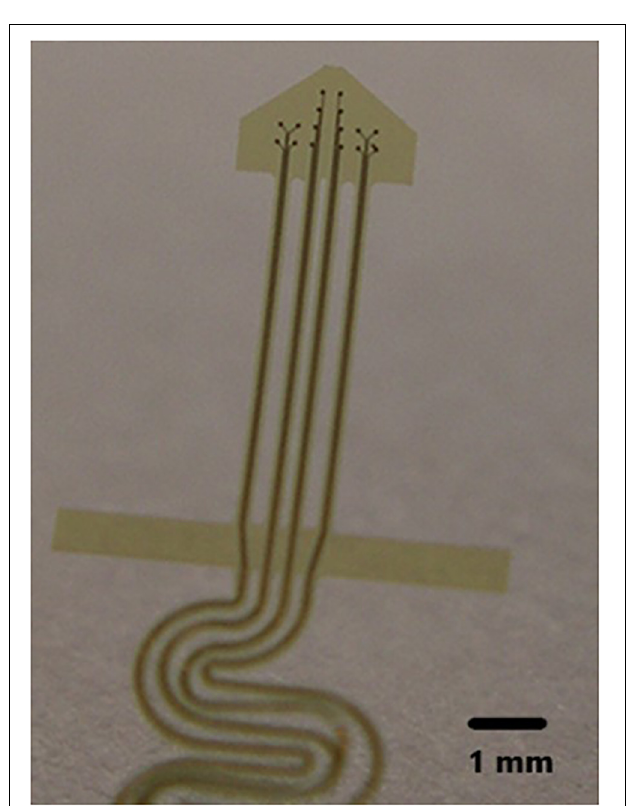
FIGURE 10 | Illustration of a polyimide